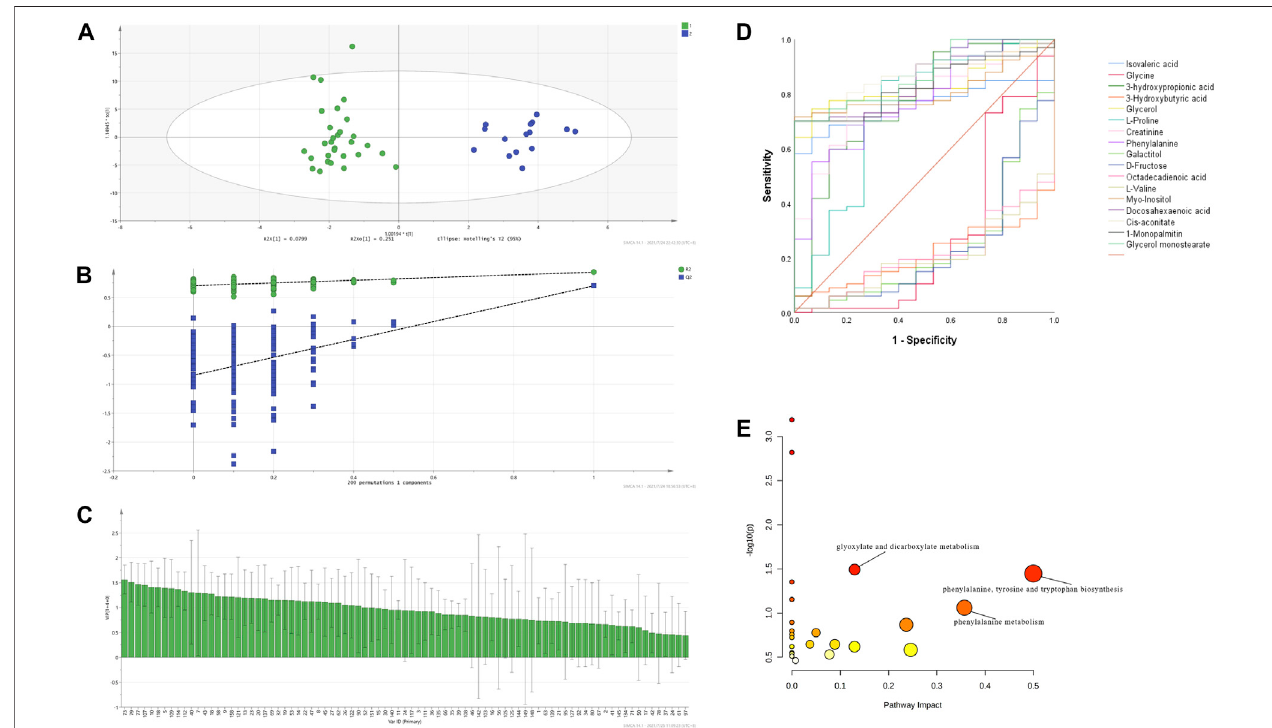
FIGURE 2 | ITP exhibited a particular metabolomic pro fi le with diagnostic potential. OPLS-DA model based on the data from the ITP patients and HCs (A) score scatterplot (B) 200randompermutationtests (C) VIPplot (D) ROCofthe17differentialmetaboliteswithbiomarkerpotentialinITPinthetestset (E) MetPAofdifferential plasma metabolites in ITP